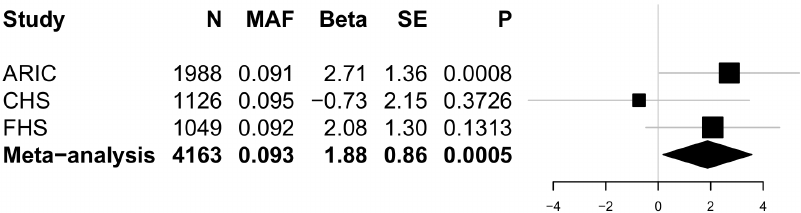
Figure 1. Forest plot for rs11191416 in relation to SBP. The beta estimate and standard error are reported from the unconditional weighted analyses. P-values are reported from unconditional unweighted analyses.